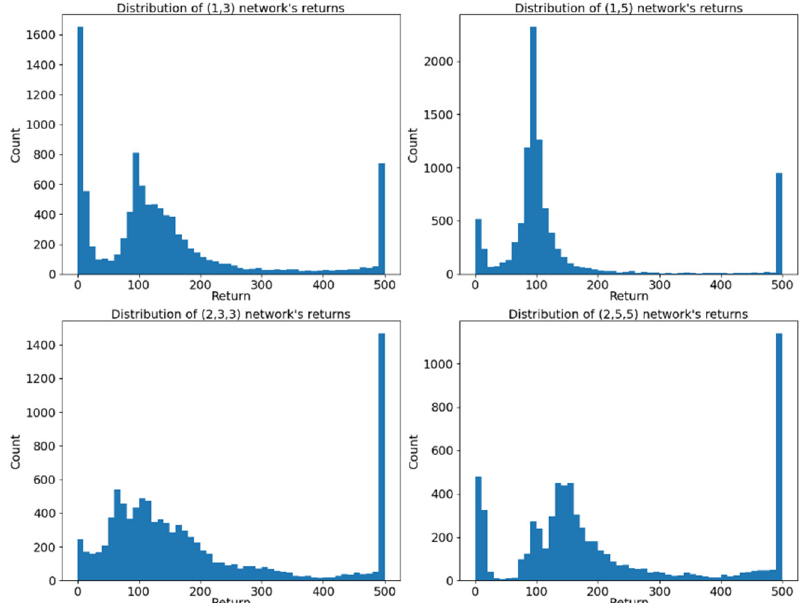
Figure 6. Return distribution of each neural network architecture.